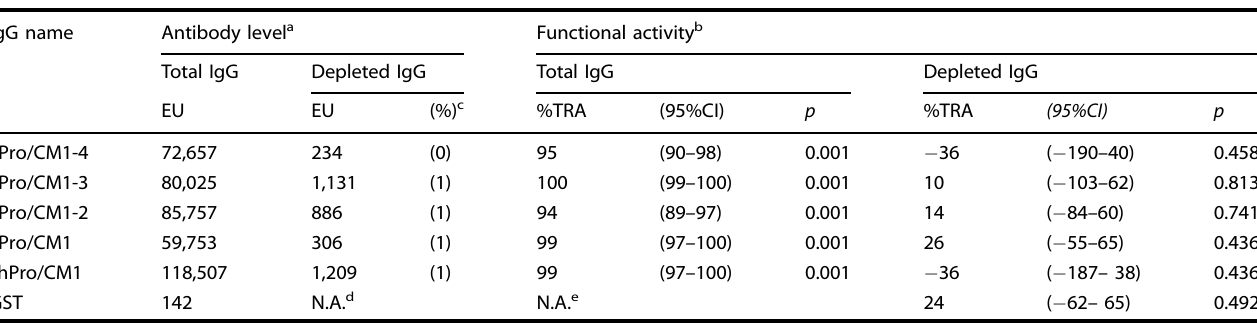
Table 1. IgG depletion with cPro/CM1-2 protein.